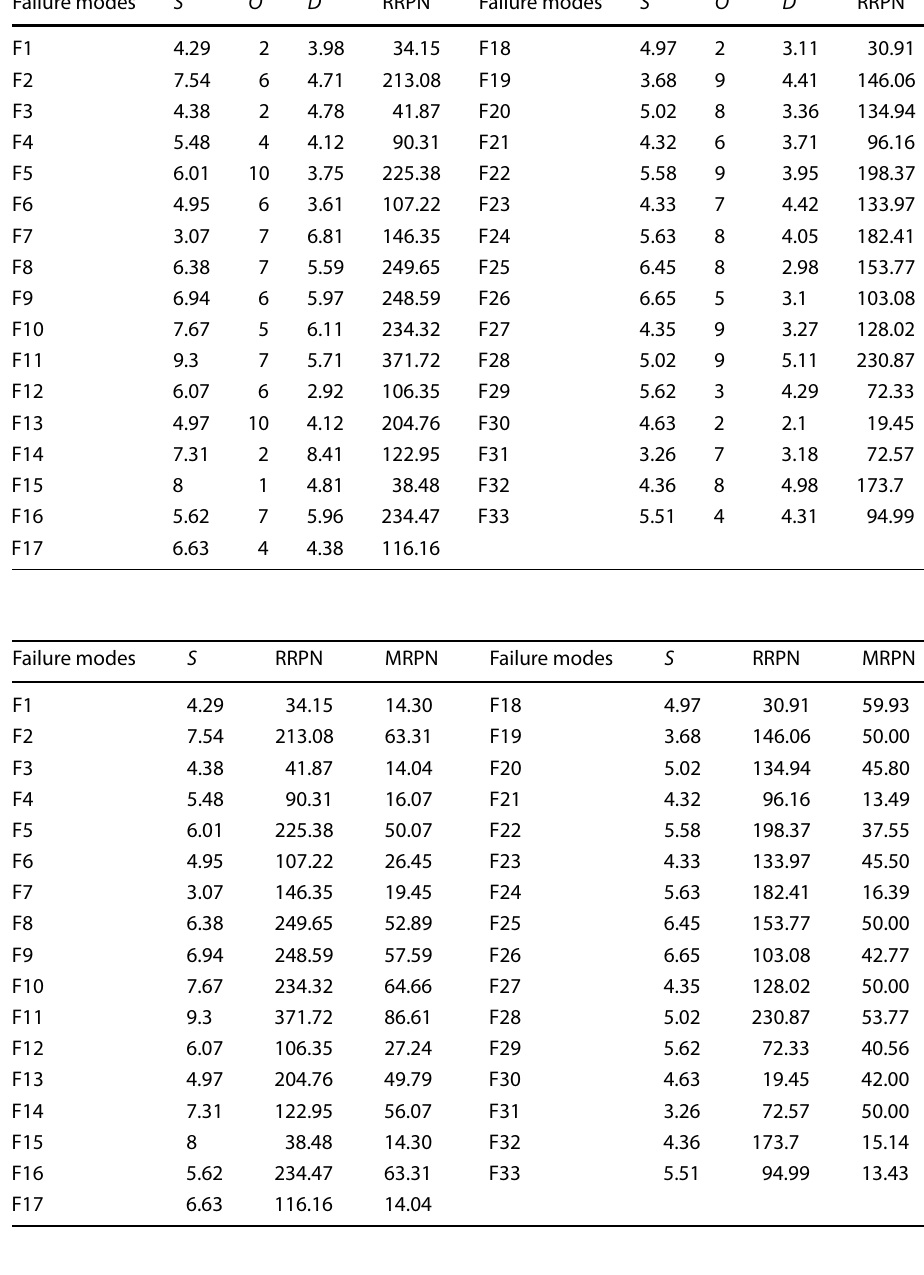
Table 8 Values of raw risk priority number (RRPN) for failure modes